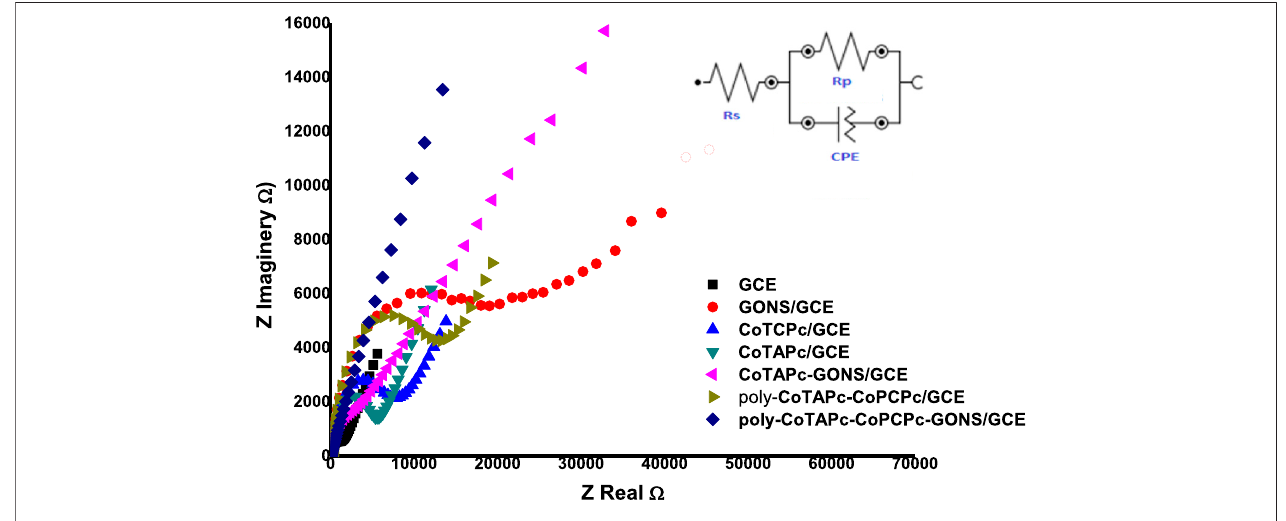
FIGURE 4 | Nyquist plots for the modi fi ed glassy carbon plots in a 0.2 mM Fe 2+/3+ redox system at 0.3 V (inset: Randles equivalent circuit).